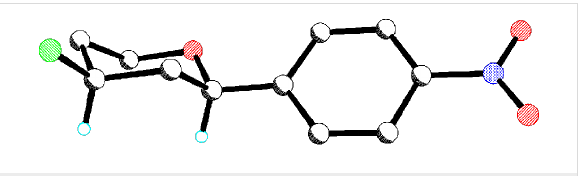
Figure 1: X-ray crystal structure of syn - 5a .